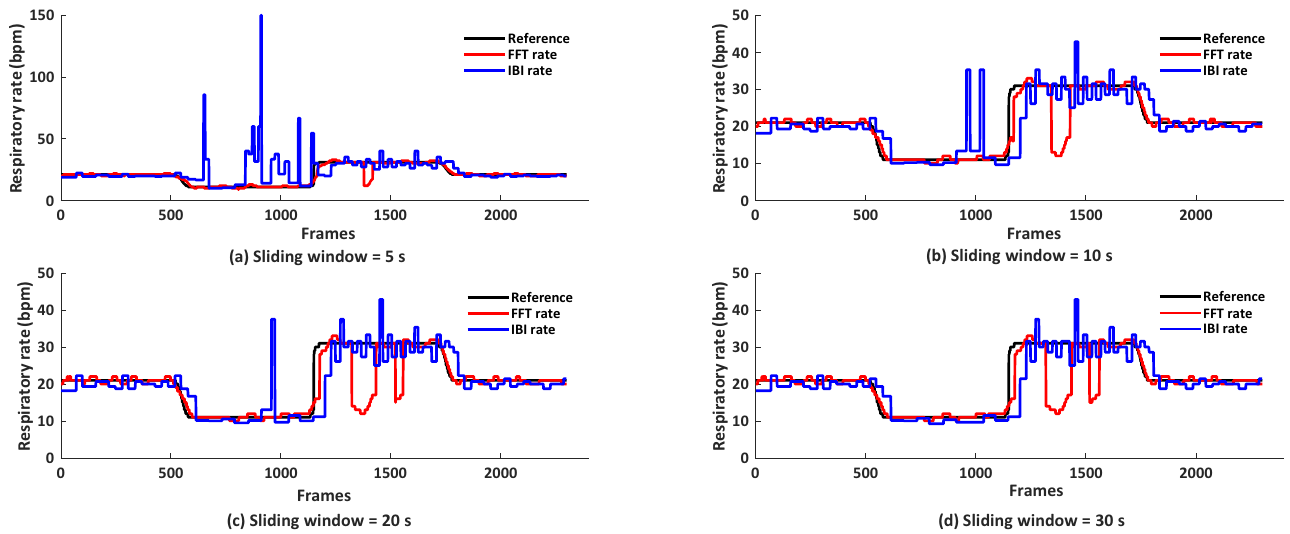
Figure 8. FFT-based and IBI-based respiratory rates obtained by FVP-AVG under different sliding window lengths on Dataset A, where subject wears a face mask at the sensor distance of 30